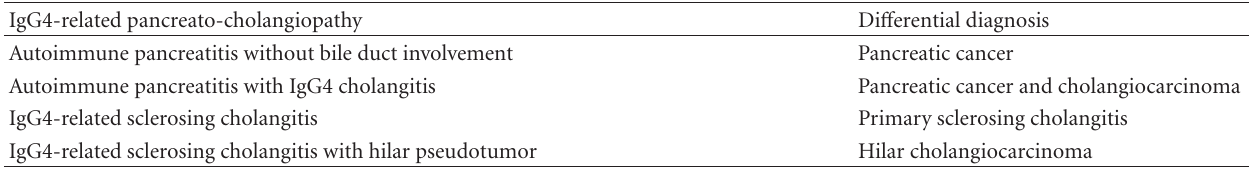
Table 1: Disease spectrum of IgG4 pancreato-cholangiopathy and di ff erential diagnosis.